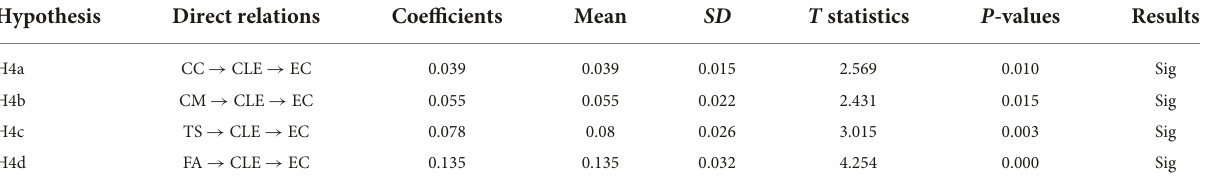
TABLE 8 Indirect